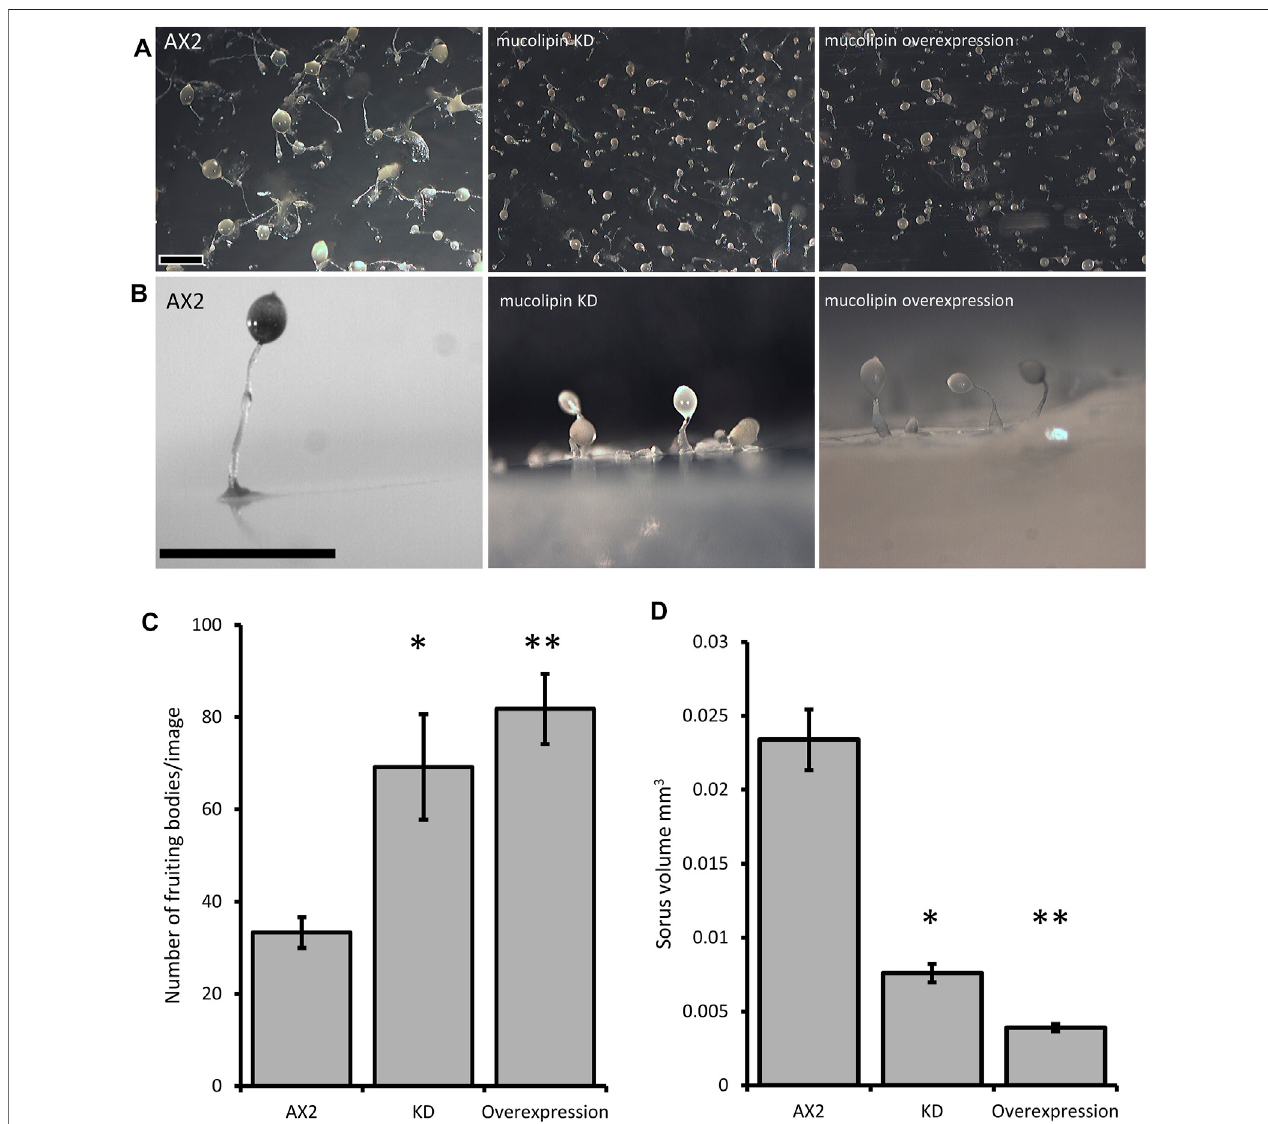
FIGURE 8 | Mucolipin knockdown and overexpression strains form smaller more numerous fruiting bodies. (A) AX2 wild type, mucolipin KD (knockdown) strain HPF817(copynumber450)andmucolipinoverexpressionstrainHPF825(copynumber600).Cellsgrownonlawnsof E.aerogenes at21 ° Cfor~24 huntilfruitingbodies had formed which were photographed from above. (B) The same strains photographed from the side. Both increasing and decreasing mucolipin expression results in very small fruiting bodies compared to that of AX2. In high copy number strains the stalks and basal disks are thickened and enlarged. Scale bar = 1 mm. (C) The number offruiting bodies were signi fi cantly increased in mucolipin knockdown and overexpression strains. Images were taken from above at the same magni fi cation for all strains and the number of fruiting bodies in the same area of photograph were counted and the means calculated. (AX2: n = 3; KD: n = 5, overexpression: n = 5) (independent t -test * p = 0.0470 vs. AX2, ** p = 0.00303 vs. AX2). (D) Sorus volume wassmaller in theknockdown and overexpressionstrainsthan AX2. Sorus area was quanti fi ed from photographs of fruiting bodies from above using the ImageJ measurement tool and then converted to volume on the assumption that the sorus is approximately spherical using equation (V = 4/3*A/sqrt (A/pi) (A = area) and presented as mm 3 . For each strain 30 – 111 sori were measured. The sorus size was signi fi cantlyreducedinknockdown( p =2.402×10 – 20 vs.AX2)andoverexpressionstrains(** p =1.8998×10 – 56 vs.AX2).Samplesizes:AX2 — N=3images, n =97sori; KD — N = 5 strains, n = 349 sori; overexpression — N = 5 strains, n = 298 sori) (independent t -test).